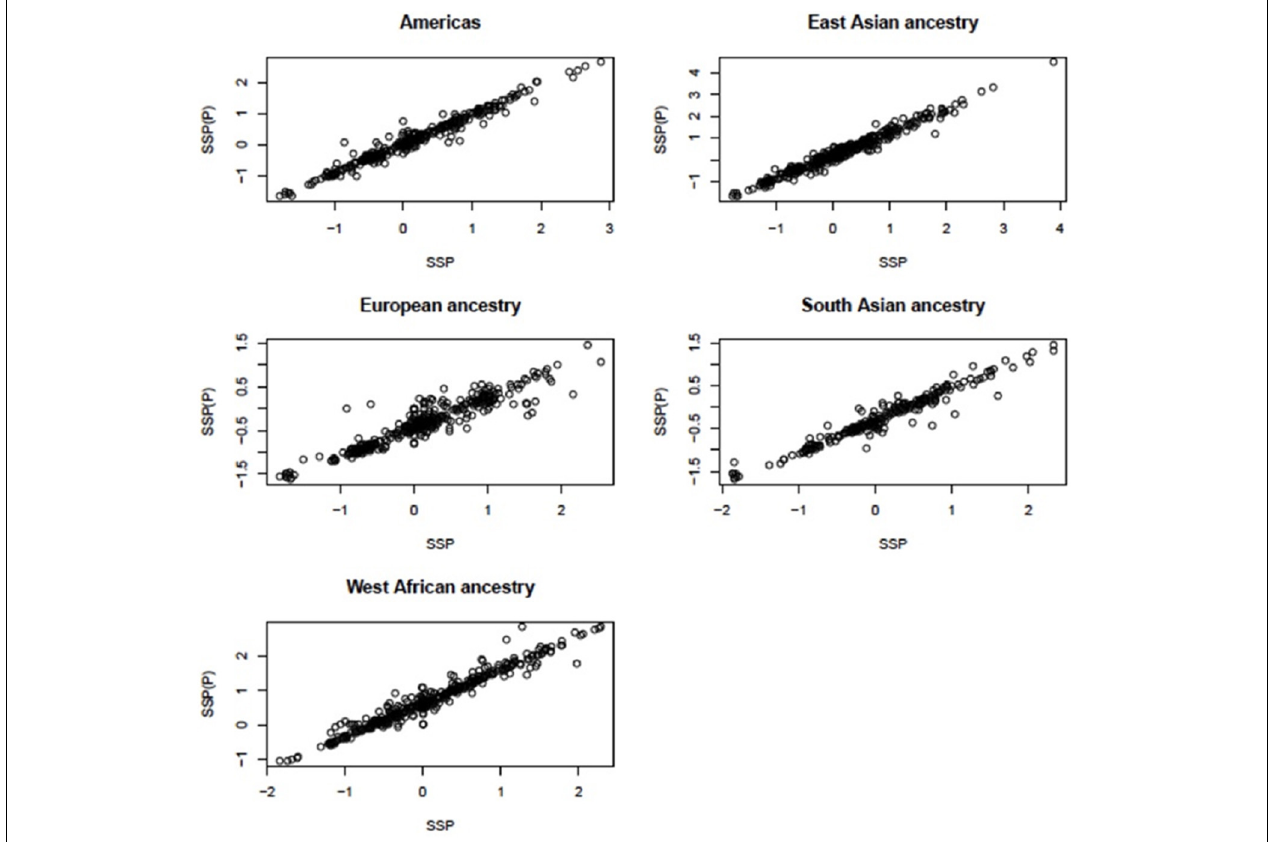
FIGURE 2 | Linear relationship between the segmentation scores called for single populations and for all populations at CCL3L1 . SSP, the segmentation scores of a single large population; SSP( P ), the segmentation score of pooled